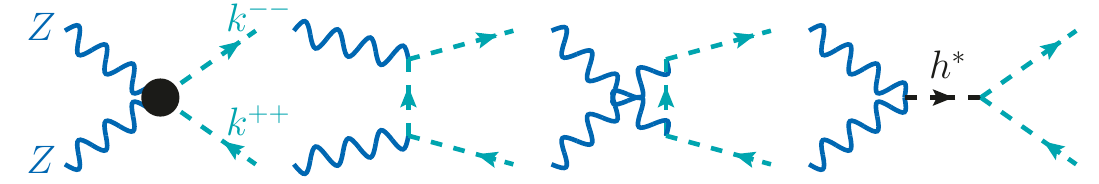
Figure 1 . Born diagram for ZZ → k −− k ++ in the Zee-Babu model. Graphs drawn with JaxoDraw